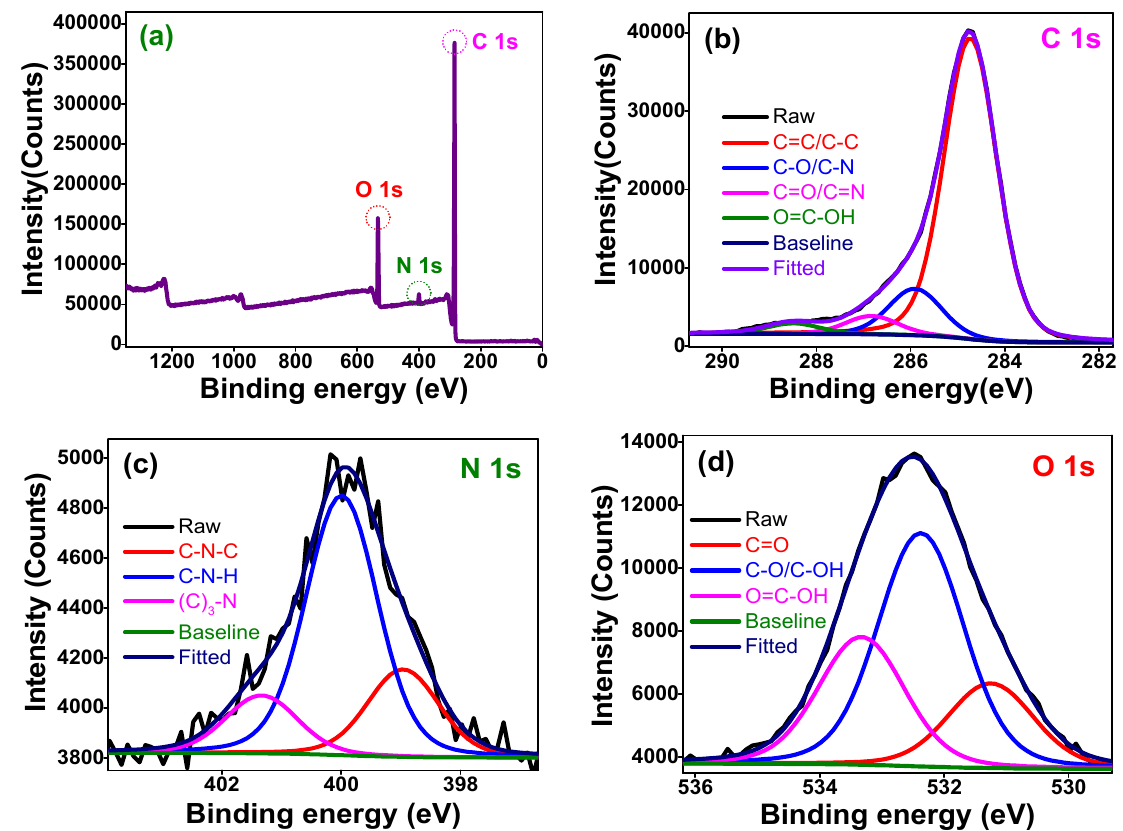
Figure 3. ( a ) XPS survey spectrum and the corresponding high-resolution C 1s ( b ), N 1s ( c ), and O 1s ( d ) spectra of the synthesized hydrophilic O -CDs.